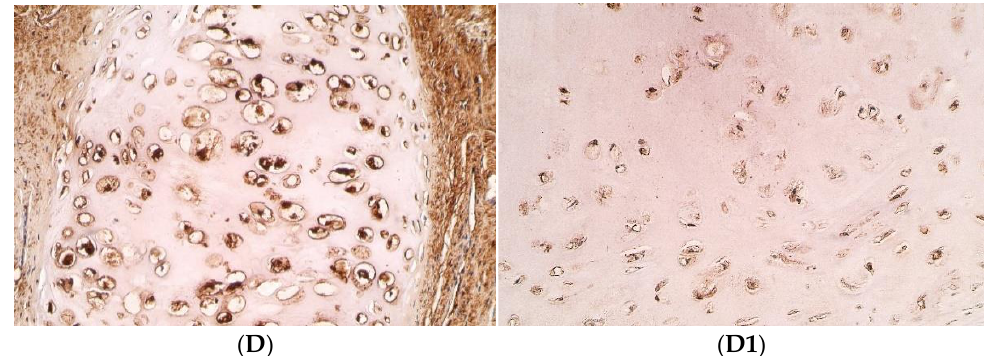
Figure 2. Immunohistochemical microphotographs of relative number of cells of various factors in cartilage in the CLP patients and the control patients. ( A ) +++ IL- 1α positive chondrocytes found in the cartilage of 11 years and 9 months old CLP patient from second-time surgery, IMH, ×250. ( A1 ) ++ IL- 1α positive chondrocytes found in the cartilage of a control patient, IMH, ×250. ( B ) +++ IL-10 positive chondrocytes found in the cartilage of 8 years old CLP patient from second-time surgery, IMH, ×200. ( B1 ) ++ IL-10 positive chondrocytes found in the cartilage of a control patient, IMH, ×200. ( C ) +++/++++ bFGF positive chondrocytes found in the cartilage of 8 years and 3 months old CLP patient from second-time surgery, IMH, ×250. ( C1 ) ++ bFGF positive chondrocytes found in the cartilage of a control patient, IMH, ×250. ( D ) +++ TGFβ1 positive chondrocytes found in the cartilage of 8 years and 3 months old CLP patient from second-time surgery, IMH, ×250. ( D1 ) ++/+++ TGFβ1 positive chondrocytes found in the cartilage of a control patient, IMH, ×250.